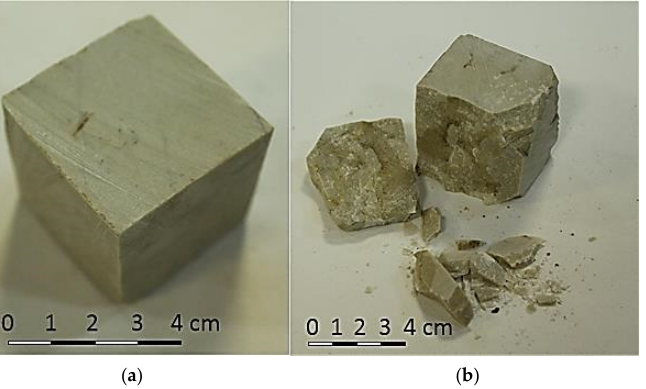
Figure 6. Disintegration of dolomitic limestone sample during repeated freezing and thawing: ( a ) soil sample prepared from borehole cores; ( b ) disintegration of the soil sample after 780 cycles of alternating freezing and thawing under la- boratory conditions.